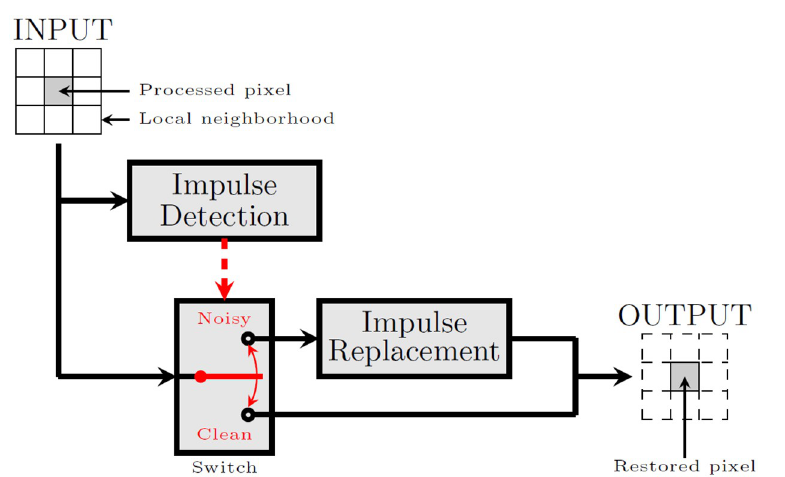
Fig 1. Switching filter for impulsive noise